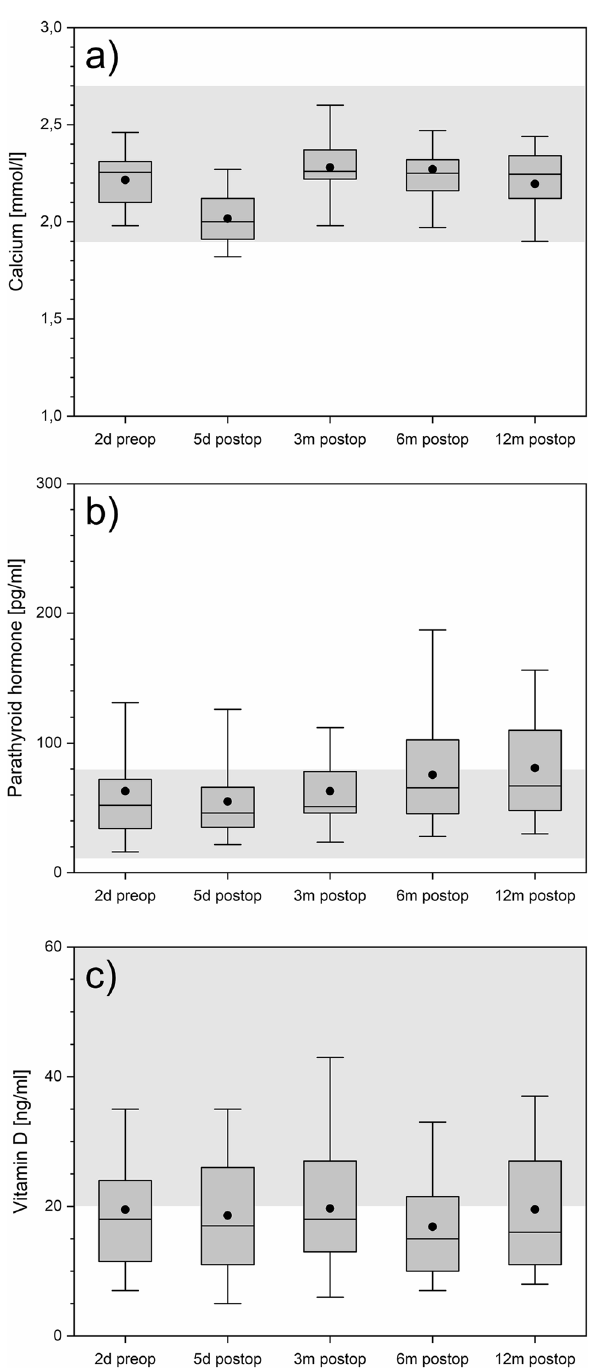
Figure 7. Calcium (panel a ), parathyroid hormone (panel b ), and vitamin D (panel c ) over time. The boxes contain the 25% and the 75% quartile as well as the median, black dots depict the mean, and whiskers range from the 5% percentile to the 95% percentile. Gray areas depict the normal range for each